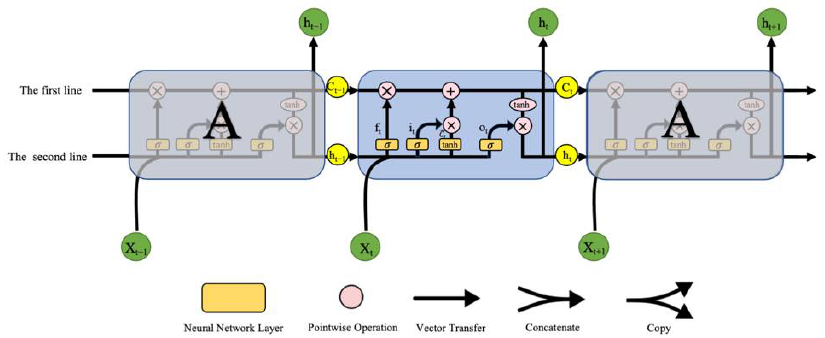
Figure 2. Schematic representation of the computational process for the fundamental LSTM struc- ture.